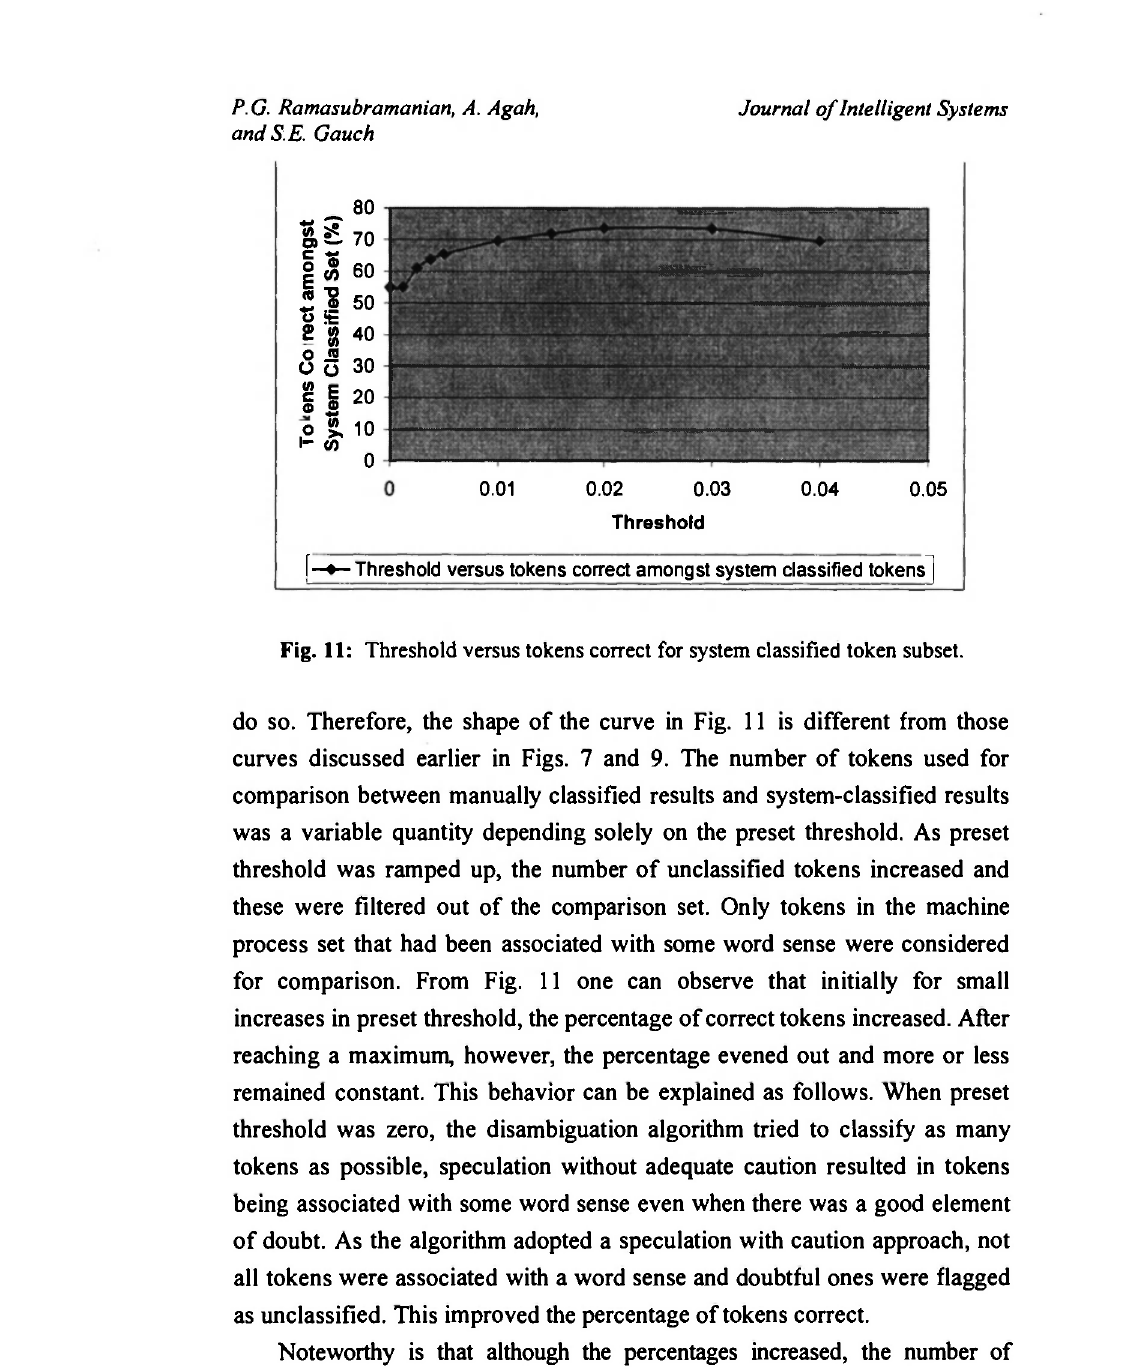
do so. Therefore, the shape of the curve in Fig. 11 is different from those curves discussed earlier in Figs. 7 and 9. The number of tokens used for comparison between manually classified results and system-classified results was a variable quantity depending solely on the preset threshold. As preset threshold was ramped up, the number of unclassified tokens increased and these were filtered out of the comparison set. Only tokens in the machine process set that had been associated with some word sense were considered for comparison. From Fig. 11 one can observe that initially for small increases in preset threshold, the percentage of correct tokens increased. After reaching a maximum, however, the percentage evened out and more or less remained constant. This behavior can be explained as follows. When preset threshold was zero, the disambiguation algorithm tried to classify as many tokens as possible, speculation without adequate caution resulted in tokens being associated with some word sense even when there was a good element of doubt. As the algorithm adopted a speculation with caution approach, not all tokens were associated with a word sense and doubtful ones were flagged as unclassified. This improved the percentage of tokens